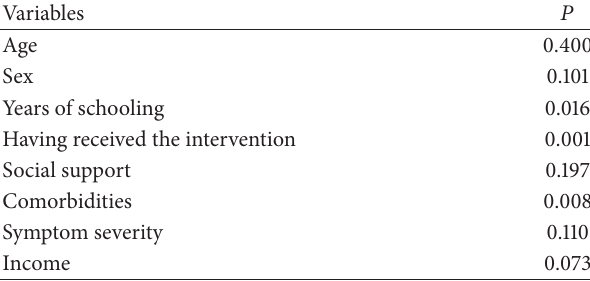
Table 2: Association between sociodemographic and clinical char- acteristics and the self-care score at the end of six